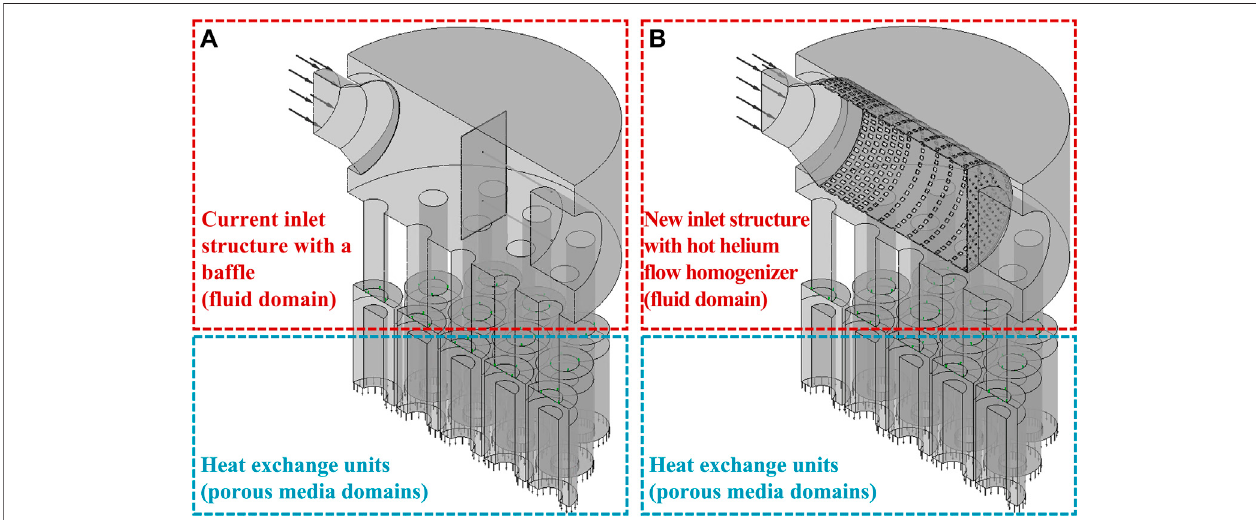
FIGURE 16 | Geometrical model of the HTGR OTSG. (A) Current inlet structure with a baf fl e. (B) New inlet structure with the fl ow homogenizer.